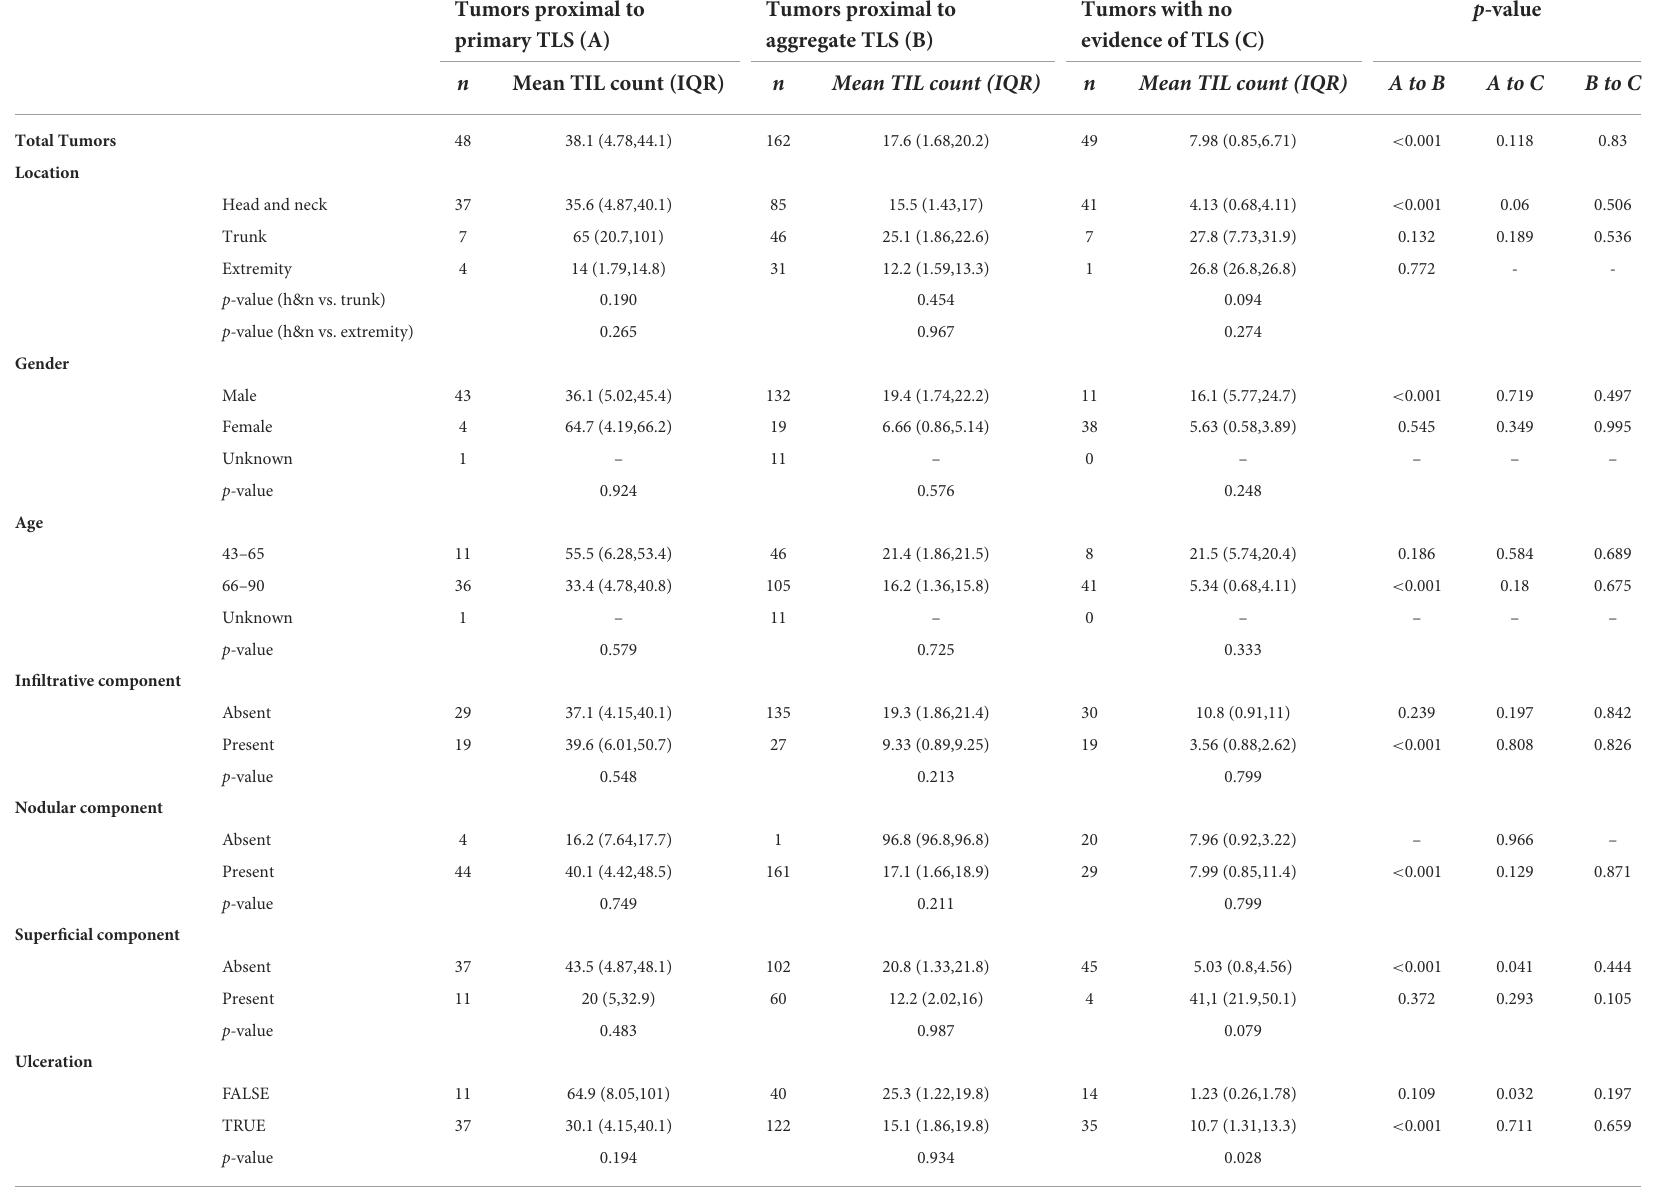
TABLE 3 Effect of TLS maturation stage and proximity to BCC on TIL count ( n represents individual